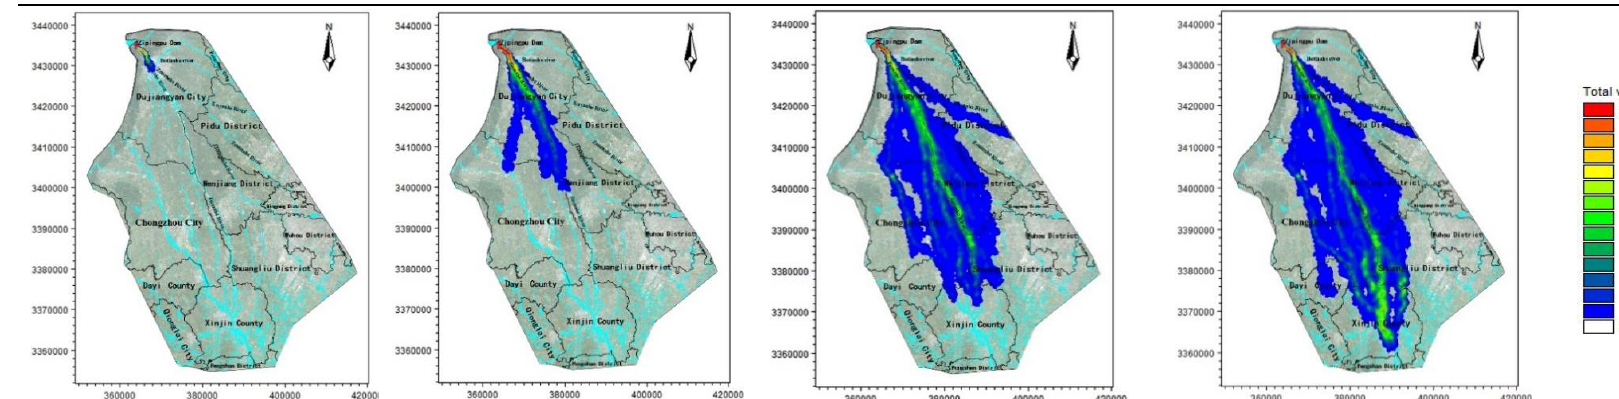
Figure 5. Scenario 3: Inundation at four time points.